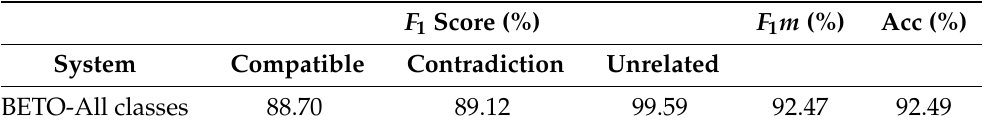
Table 3. Results obtained from Experiment 1: Predicting compatible, contradictory, and unrelated